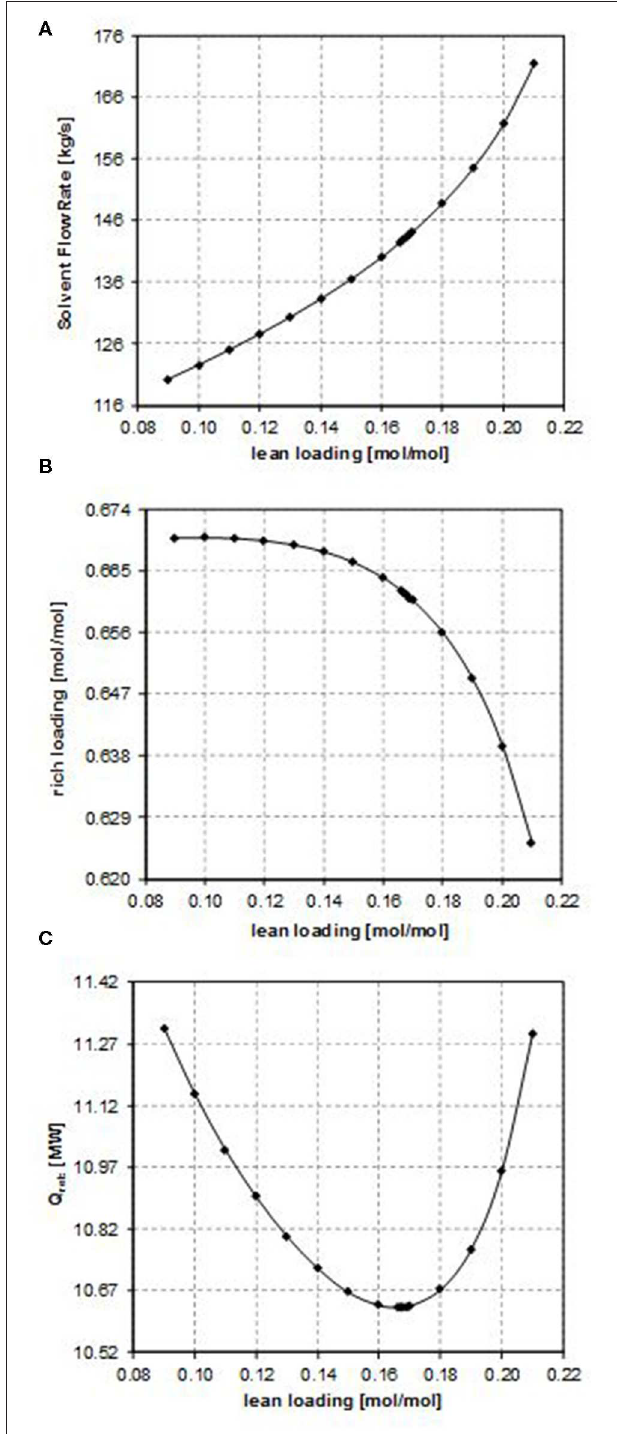
FIGURE 2 | Effect of the CO 2 lean loading on (A) the solvent flow rate, (B) the rich loading, and (C) the reboiler duty ( case B ).